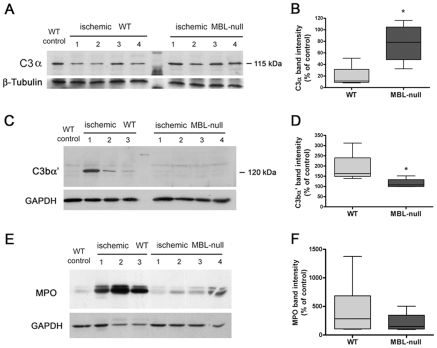
C3 activation and neutrophil infiltration in the ischemic brain is lower in MBL-null than WT mice.A) C3 α-chain is observed in control tissue with a rabbit anti-mouse C3 antibody. C3 is cleaved after ischemia in WT mice and, to a lesser extent, in MBL-null mice. Lanes represent different animals. B) Quantification of band optical density shows more severe cleavage of the C3 α-chain in WT than in MBL-null mice. C) The C3bα' fragment (120 kDa) is evidenced in the ischemic tissue with an anti-C3 antibody. D) Quantification of band optical density shows that C3bα' is more abundant in the ischemic tissue of WT than of MBL-null mice. E) Myeloperoxidase (MPO) is a marker of neutrophil infiltration in brain tissue. MPO is detected in the ischemic brain of WT mice, while it is attenuated in MBL-KO mice, as shown in F). Values are expressed as mean±SD. * p<0.05.